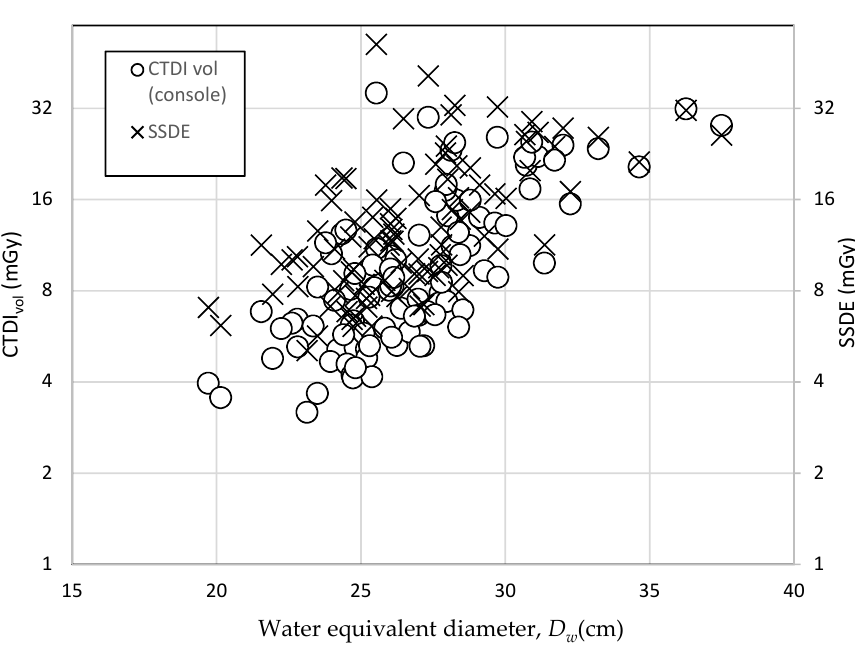
Figure 2. Relationship between CTDI vol and SSDE with D W of the subjects.